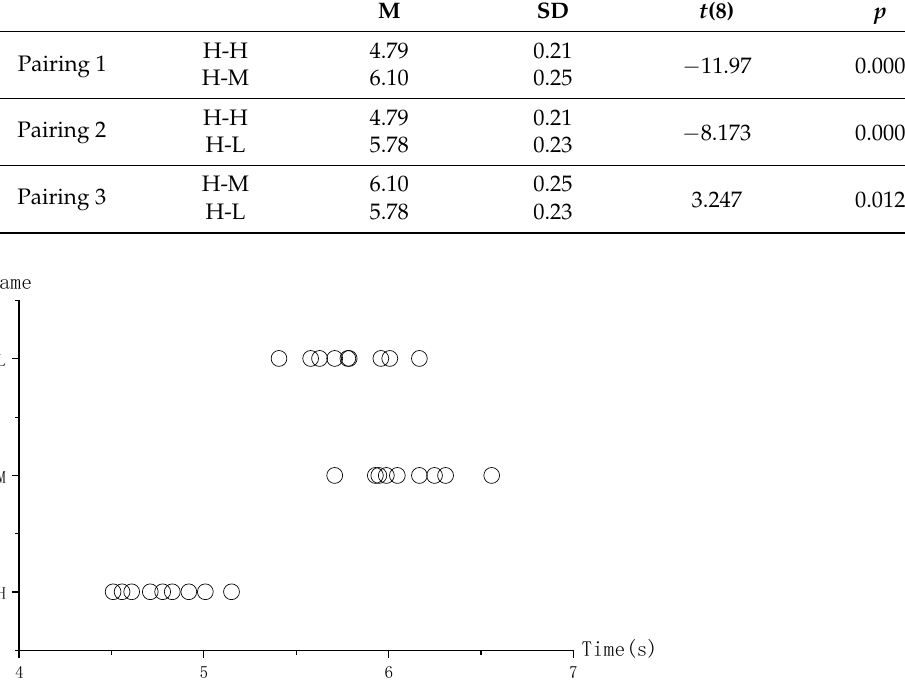
Figure 13. Wireframe diagram of each group of time data (Red represents the indication of high pitch, cyan represents the indication of medium pitch, and orange represents the indication of low pitch. H, M, and L in the group name refer to high, medium, and low, respectively; those located in front are the pitch, and those behind are the heights). Table 2. Time distribution results table of high pitch–height.